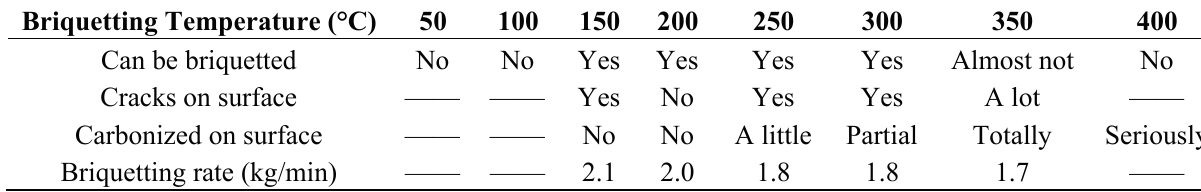
Table 3. Effect of temperature on raw residue briquetting.